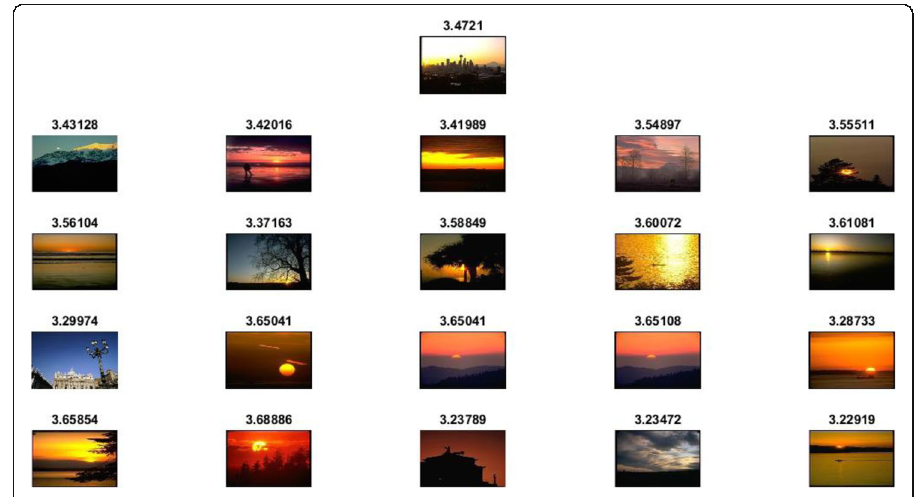
query image (first row) (LRF-0)